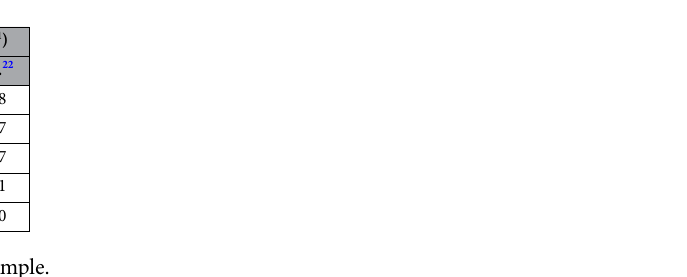
Table 1. FTIR peaks of Ag–GO